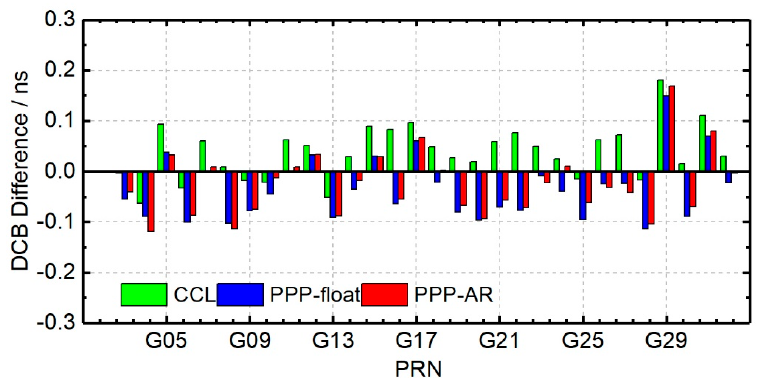
Figure 12. Averaged biases of satellite DCBs for three methods compared to CODE final monthly products from DOY 100 to 106, 2017.